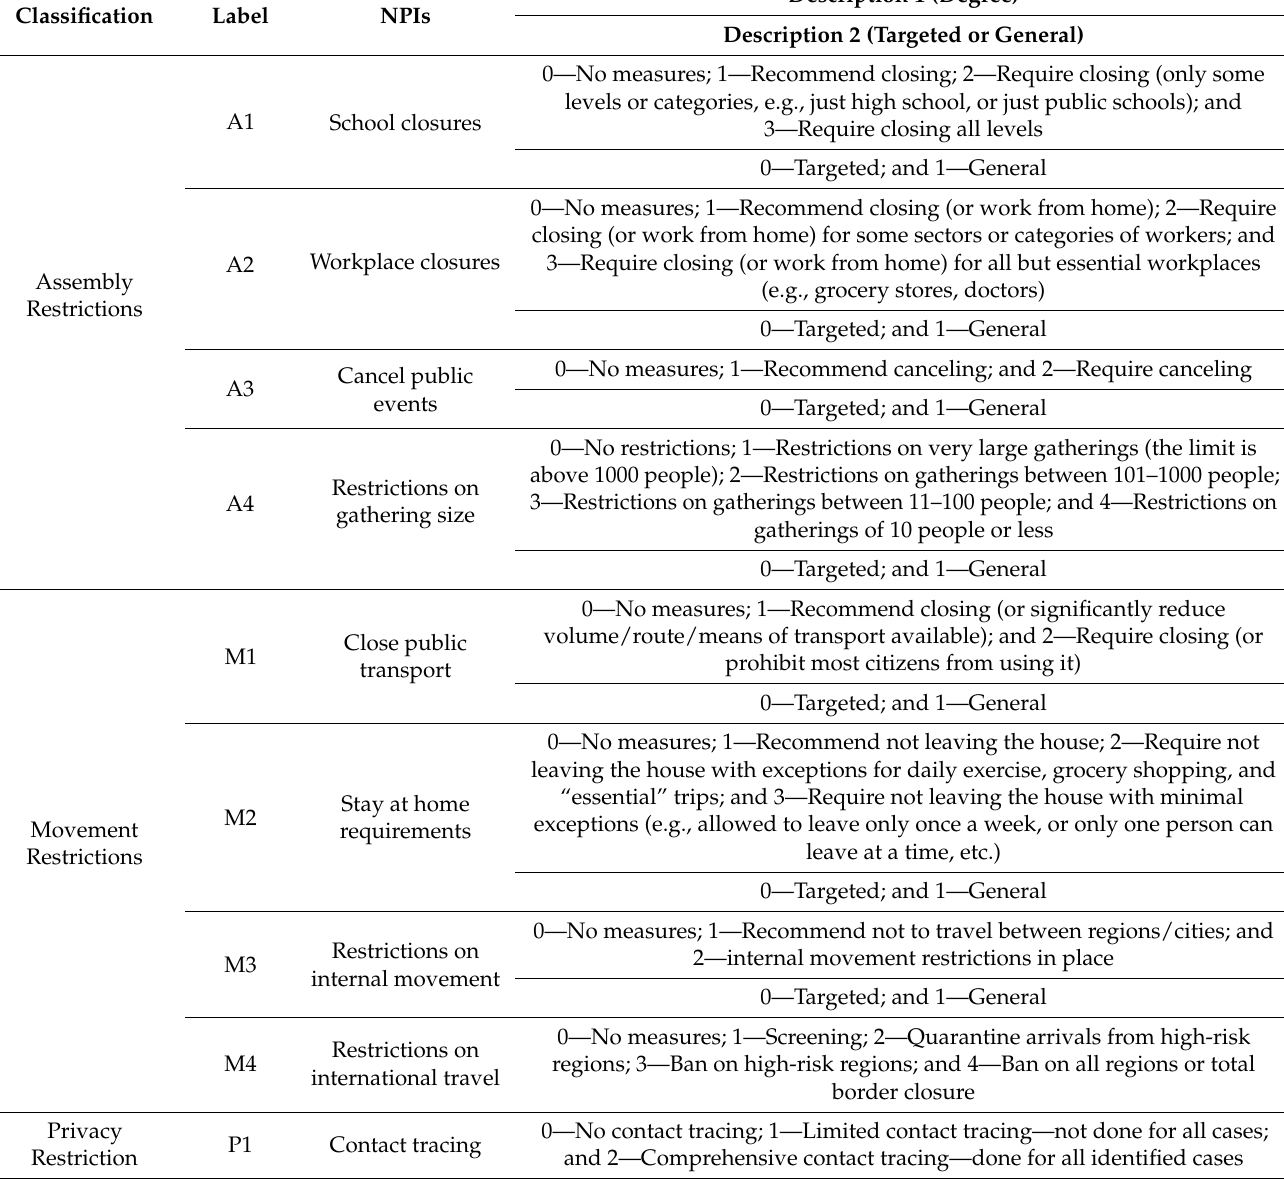
Table 1. Summary of NPIs (non-pharmaceutical interventions)